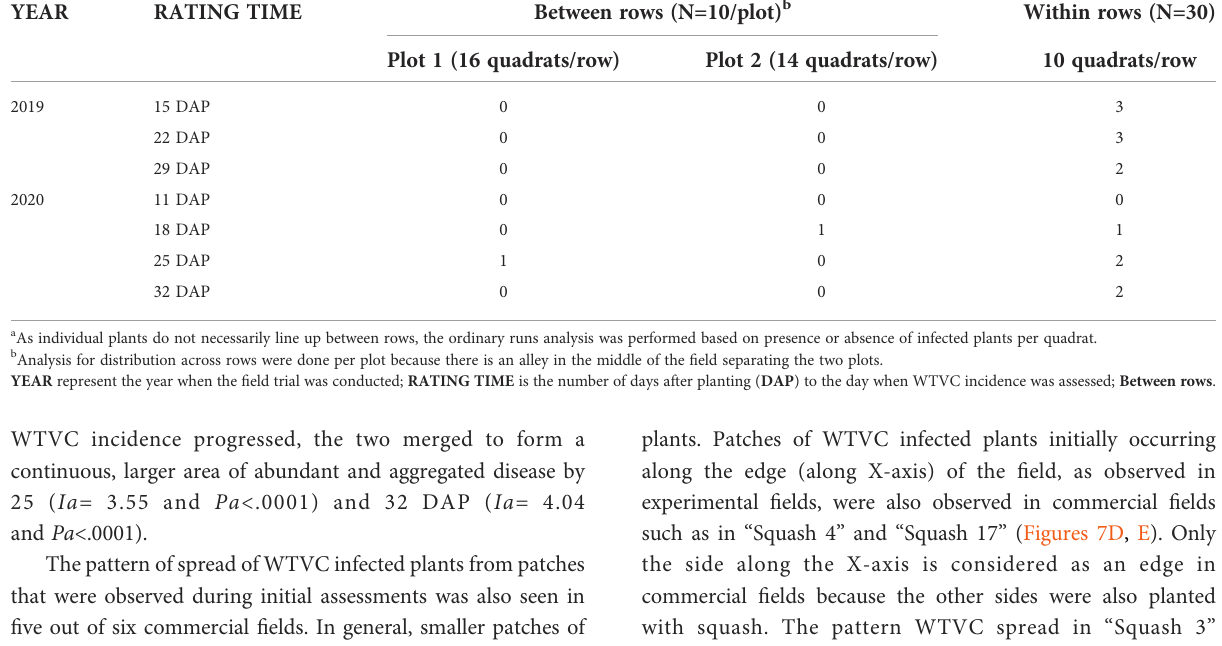
TABLE 4 Detection of aggregated distribution of virus incidence in experimental fi eld through ordinary runs analysis performed between rows versus across rows a . Between rows (N=10/plot)